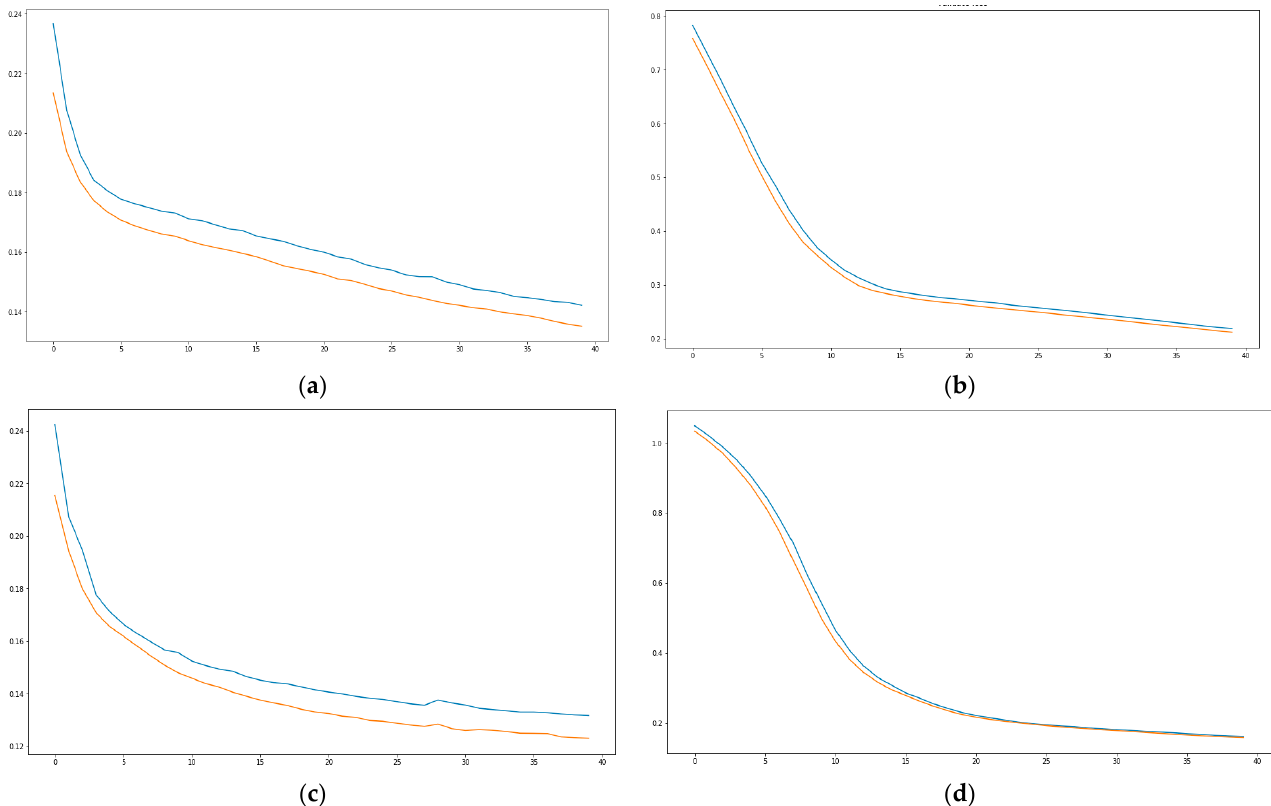
Figure 7. ( a ) Quality metrics Scenario 1, ( b ) Quality metrics Scenario 2, ( c ) Quality metrics Scenario 3, ( d ) Quality metrics Scenario 4.